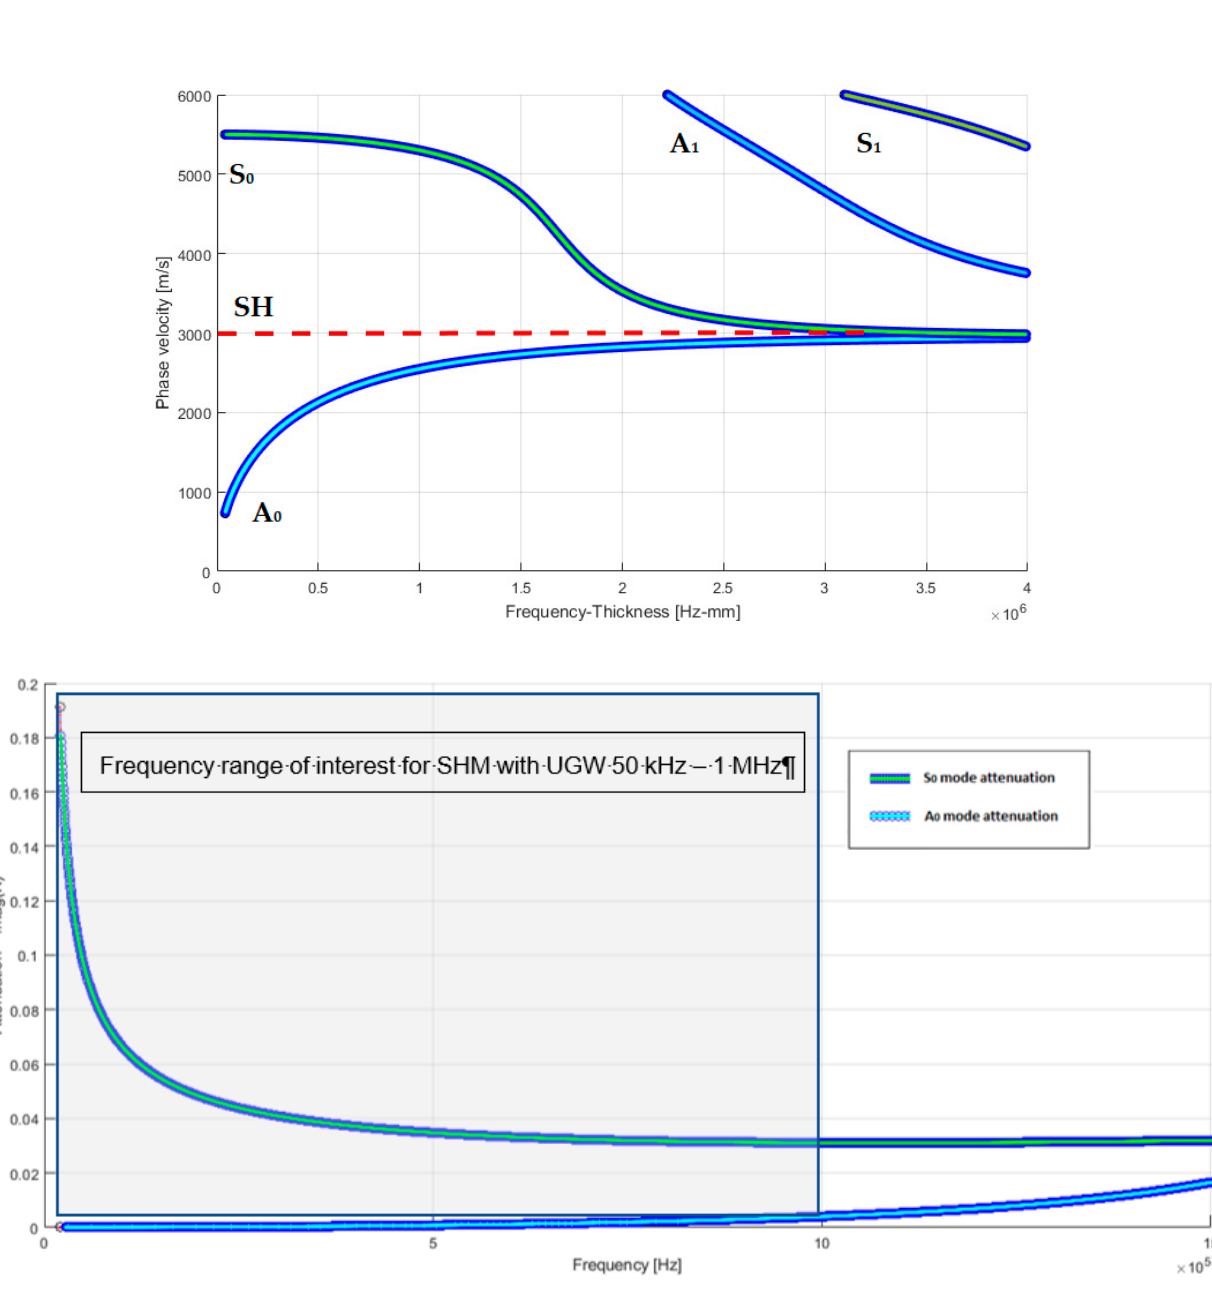
Figure 2. ( Top ) Simulated dispersion curves of phase velocity for low order modes Symmetric (S 0 ), Antisymmetric (A 0 ) and Shear Horizontal (SH) in an aluminum plate as function of the frequency × thickness product (MHz × mm). The diagram shows that higher order modes (A 1 , S 1 , etc.) are generated well above the value of 1.5 MHz × mm. ( Bottom ) Frequency dependent attenuation of Symmetric (S 0 ) and Antisymmetric (A 0 ) modes calculated as imaginary part of the complex wavenumber K for an aluminum plate 1.4 mm thick.